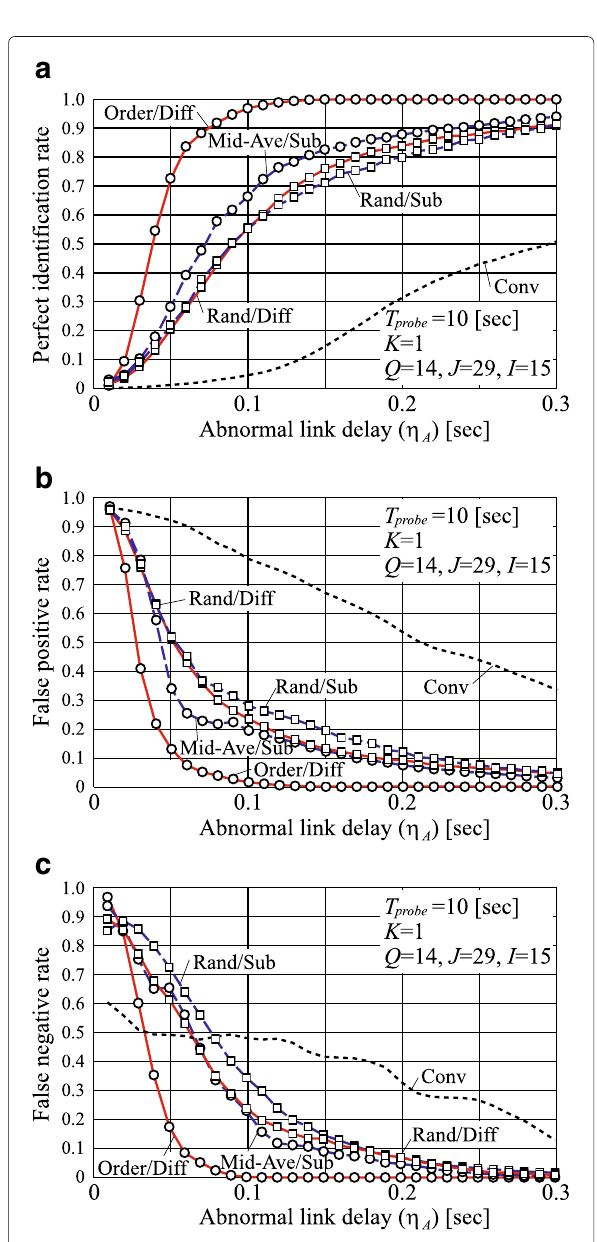
Fig.5 Dependency on the abnormal link delay. a PIR, b FPR, and c